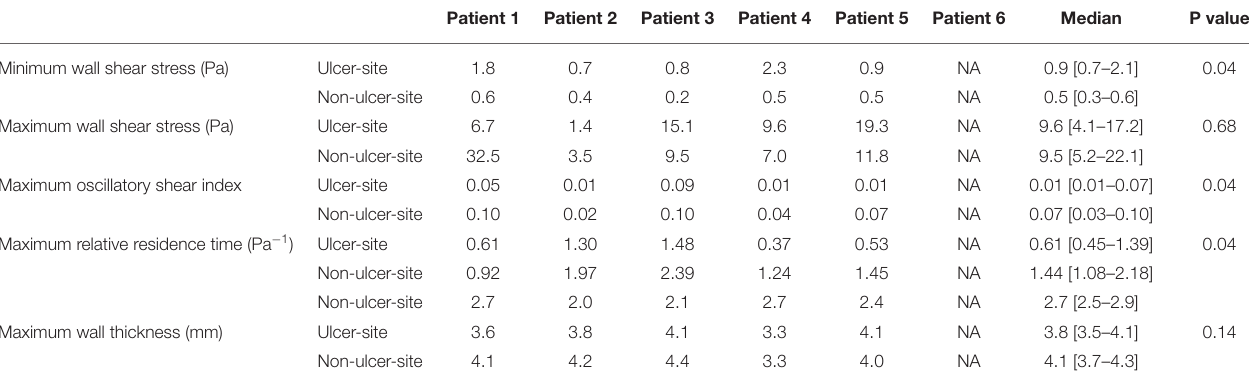
TABLE 3 | Comparison of wall shear stress and wall thickness measurements at ulcer site and non-ulcer